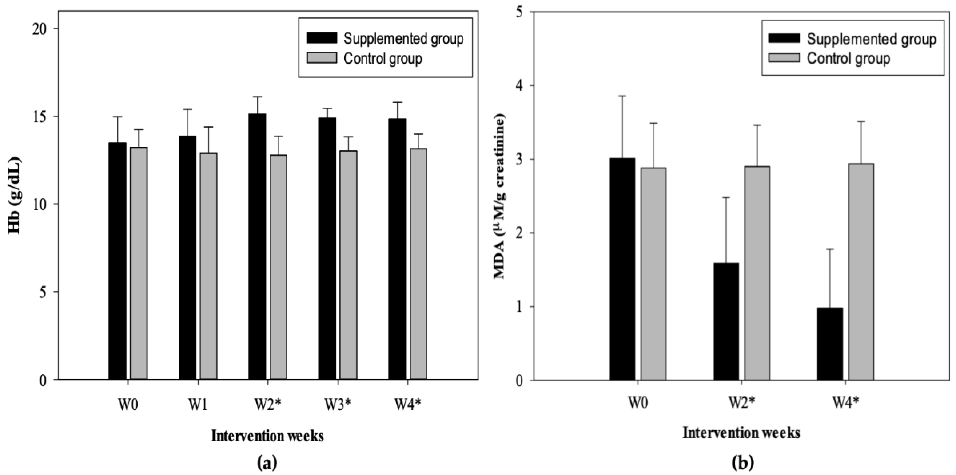
Figure 2. Concentrations of ( a ) Hb (Hemoglobin) (mean ± SD) and ( b ) UMDA (Urinary malondialdehyde) (mean ± SD) before, during, and after 4 weeks of supplementation in the supplemented and control group (W0: baseline; W1: week 1; W2: week 2; W3: week 3; W4: week 4). * Statistically significant difference between groups according to the independent samples t-Test ( p < 0.001).